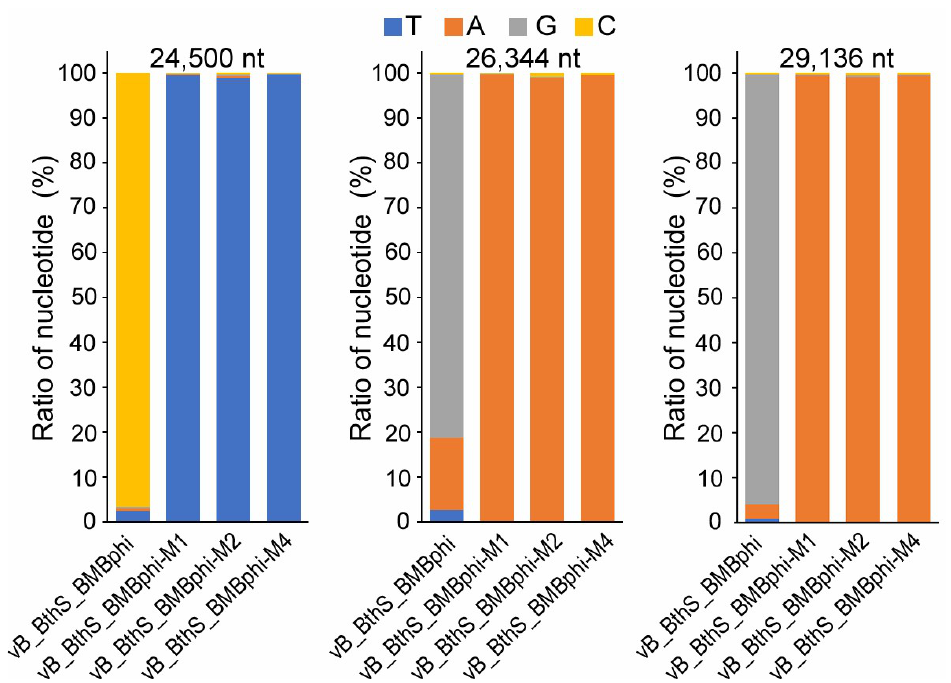
Figure 5. Polymorphism of the mutant nucleotides in phage genome. The ratio of the nucleotide compositions of the three mutant nucleotides in four phage genomes is shown. The nucleotide composition was obtained by analyzing the raw reads archived by genome sequencing and the sites of each mutant nucleotides were shown.